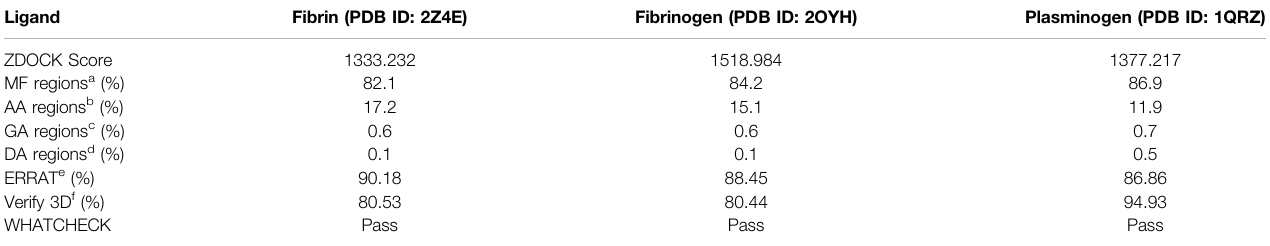
TABLE 5 | The ZDOCK Score and SAVES evaluation of docking models of EPF3.